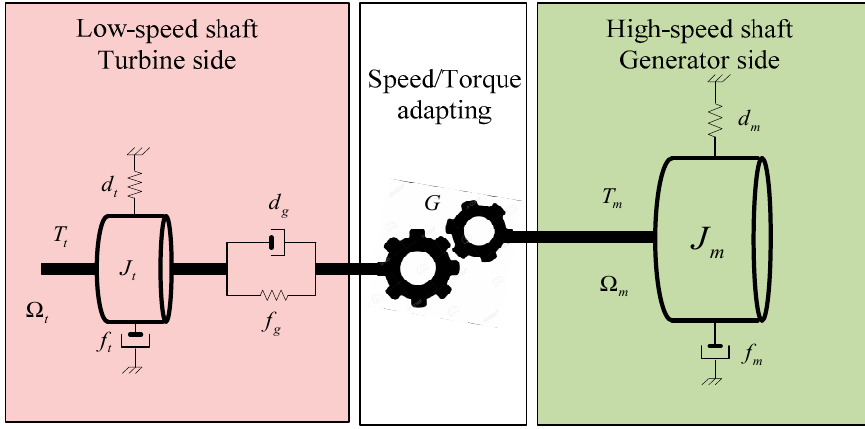
Figure 8. Simplified two-mass model of the wind turbine emulator drive train.